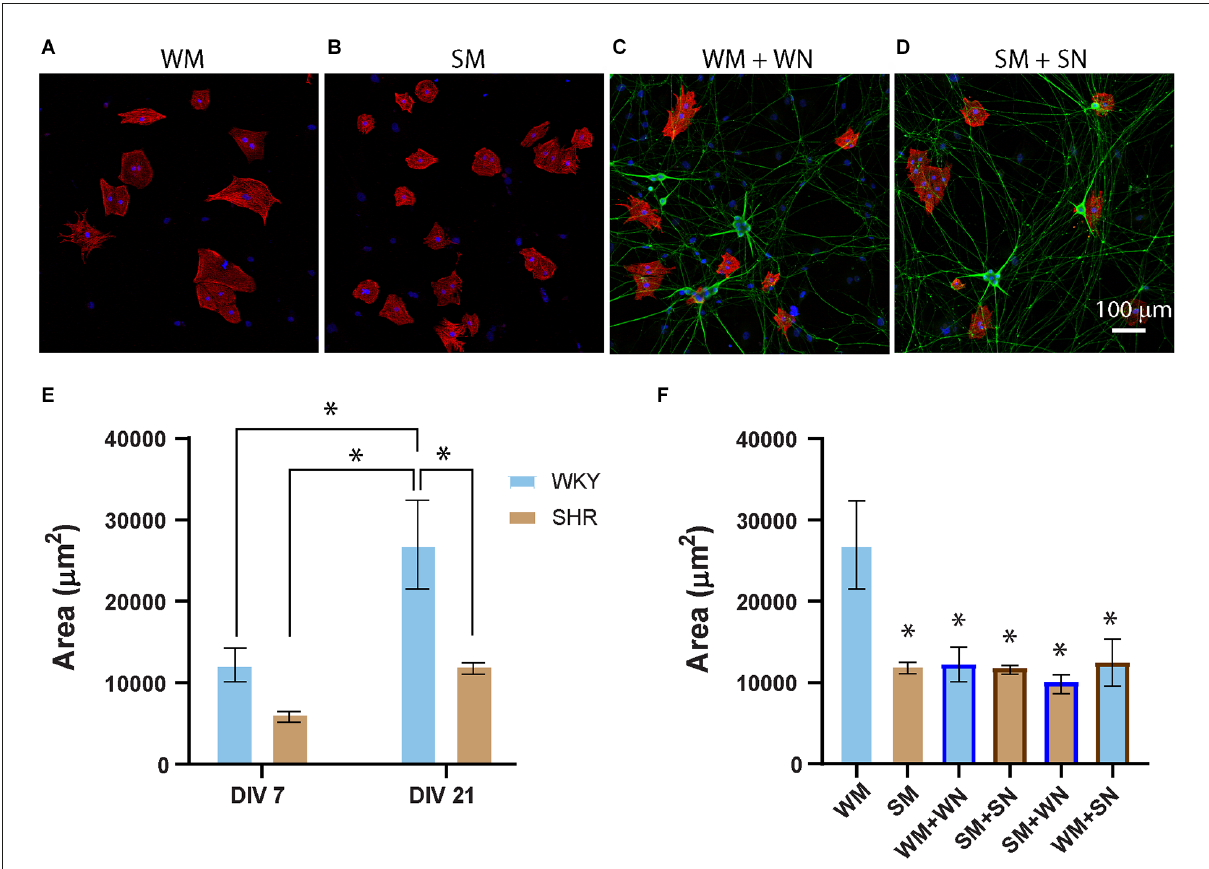
FIGURE6 SHR cardiomyocytes are smaller than WKY, and less responsive to neuronal signaling. (A–D) Representative images of WKY (A,C) and SHR (B,D) cardiomyocytes at DIV 7, grown alone (A,B) or with neurons from the same strains (C,D) , and stained for the myocyte marker cTnT (red) and the neuronal marker peripherin (green). (E) Quantification of cardiomyocyte area for cardiomyocytes grown alone (WM and SM) at DIV7 and DIV21 showing a greater size of WM, compared to SM at DIV 21 and an increase in WKY size between DIV 7 and DIV 21. (F) Comparison cardiomyocytesgrownalone(asshownin E )withsame-strain(WM+WN;SM+SN)andcross-strain(WM+SN;SM+WN)neuronalco-culturesat DIV 21. DIV 21 WM grown alone are significantly larger than cardiomyocytes in any co-culture condition. There are no differences in size between SM grown alone and the same cardiomyocytes grown in any co-culture (DIV 7: WM, n = 186 cells from N = 2 primary culture preparations; SM, n = 352 cells from N = 3 primary culture preparation. DIV21: WM, n = 101, N = 3; SM, n = 204, N = 4; WN + WM, n = 51, N = 4; SN + SM, n = 200, N = 4; WM + SN, n = 129, N = 3; SM + WM, n = 52, N = 3. Nested 1-way across all conditions with Tukey’s post-hoc analysis, ∗ p < 0.001, error bars represent s.e.m.), scale bar = 100 µ